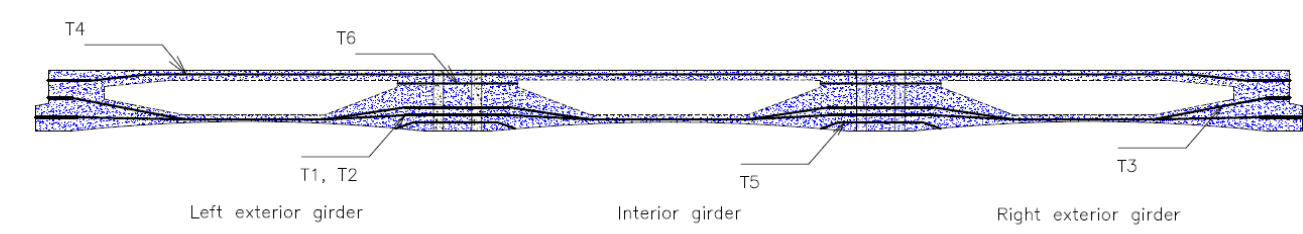
Figure 2. Details of post-tension tendons.